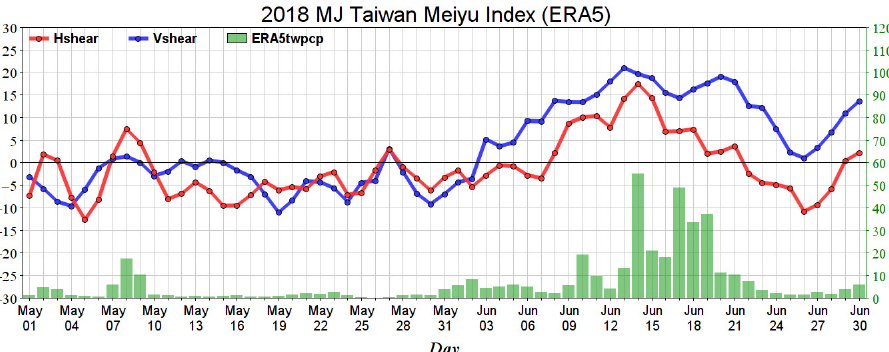
Figure 1. Time-series of Meiyu index and precipitation over Taiwan from 1 May to 30 June in 2018. The Meiyu index consists of Hshear (red line) and Vshear (bue line) and precipitation average in Taiwan (green bar). The modified index pings the onset to be 9 June when the two indices are positive, while the maximum rainfall during 9–21 June is 82 mm. The maximum rainfall during 7–8 May is 38 mm with positive Hshear and Vshear.